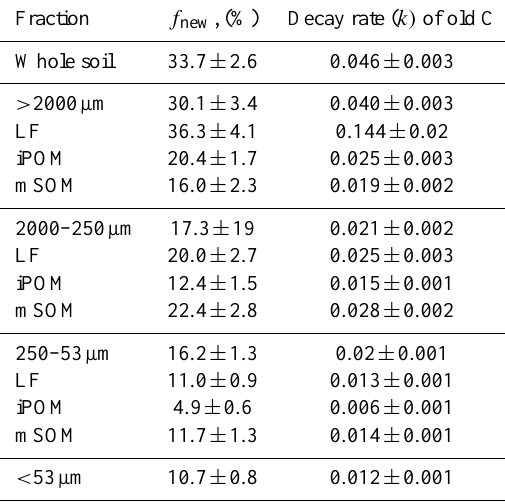
Table 6. New C input ( f new ) , and decay rate ( k , yr − 1 ) of old C of soil fractions (0–20cm) in warmed soils after nine years of experi- mental